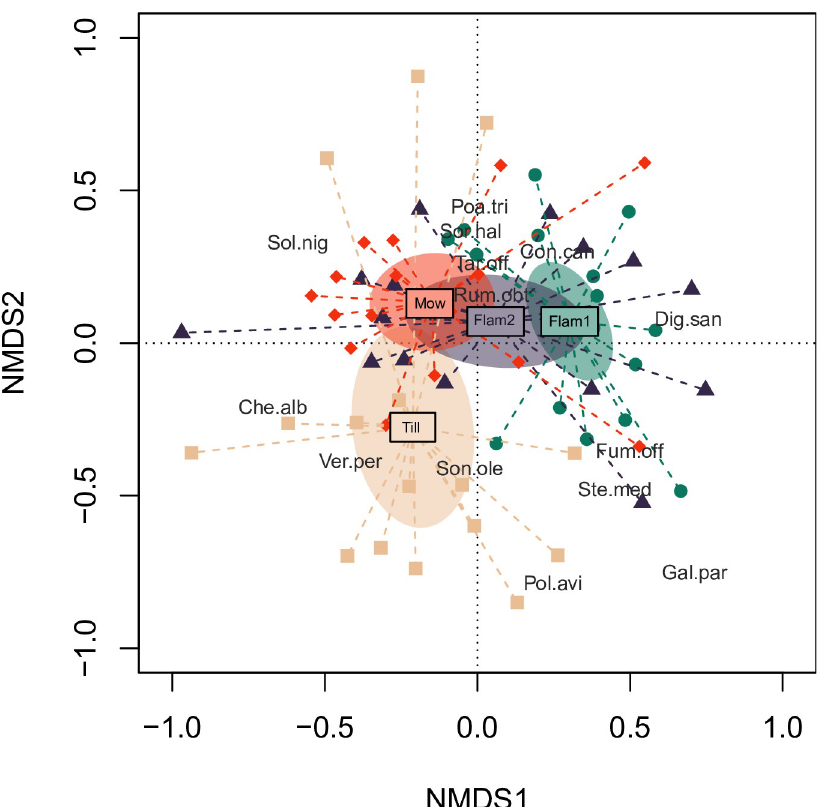
Fig 3. Non-Metric Multidimensional Scaling (NMDS) ordination. Centroids of each vineyard row treatment (i.e. Flam1 = intense flaming, Flam2 = gentle flaming, Mow = mowing, Till = tillage) and standard error of the average of scores (shaded elliptic area with 95% confidence limit) are reported. A selection of species was plotted according to species scores and further abundance priority selection (Che.alb = Chenopodium album , Con.can = Conyza canadensis , Dig.san = Digitaria sanguinalis , Fum.off = Fumaria officinalis , Gal.par = Galinsoga parviflora , Poa.tri = Poa trivialis , Pol.avi = Polygonum aviculare , Rum.obt = Rumex obtusifolius , Sol.nig = Solanum nigrum , Son.ole = Sonchus oleraceus , Sor.hal = Sorghum halepense , Ste.med = Stellaria media , Tar.off = Taraxacum sect. Taraxacum , Ver.per = Veronica persica ).